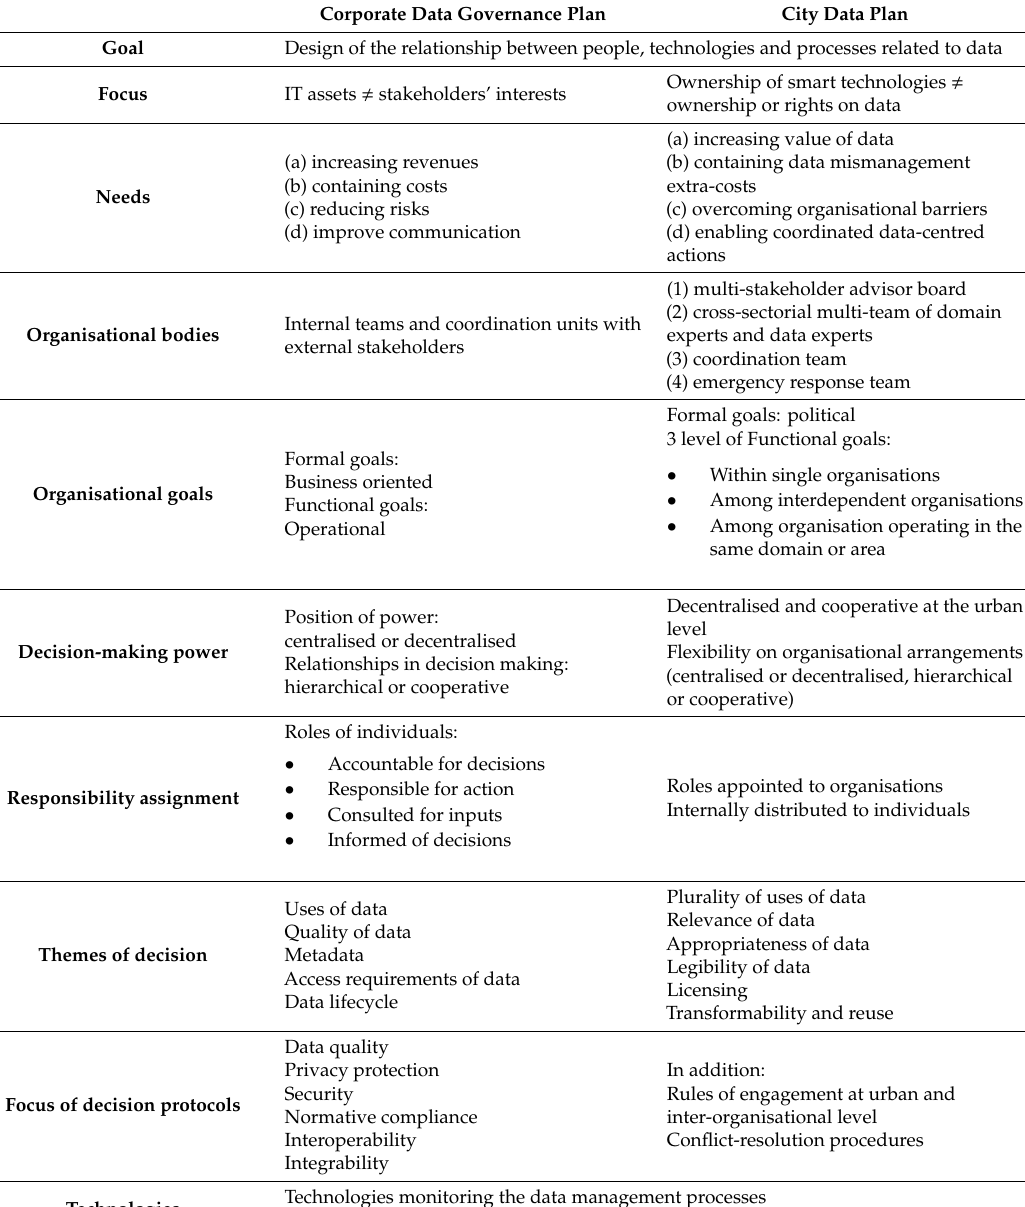
Table 1. Overview of the key aspects of corporate data governance plans informing the conceptualisation of the City Data Plan (source: author’s